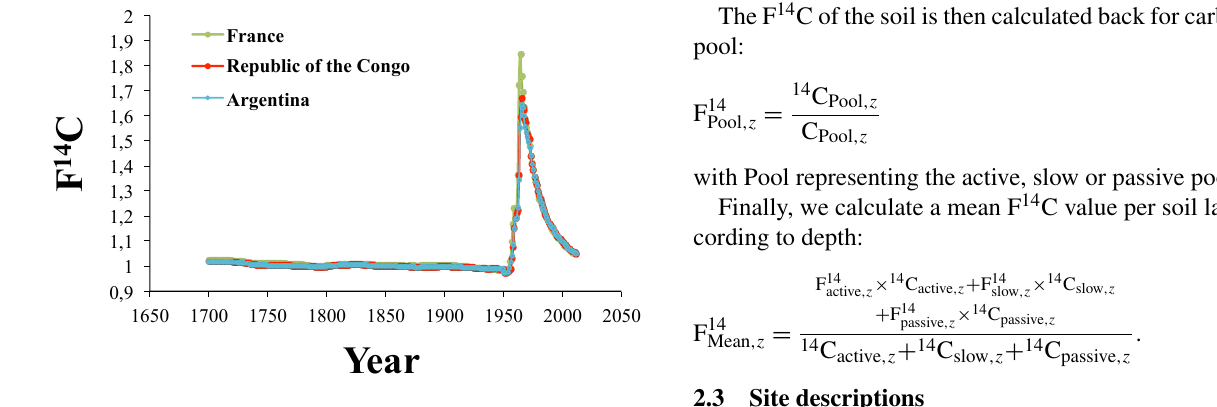
Figure 2. Evolution of the F 14 C of atmospheric CO 2 in Argentina, Republic of the Congo and France (data from Hua et al.,